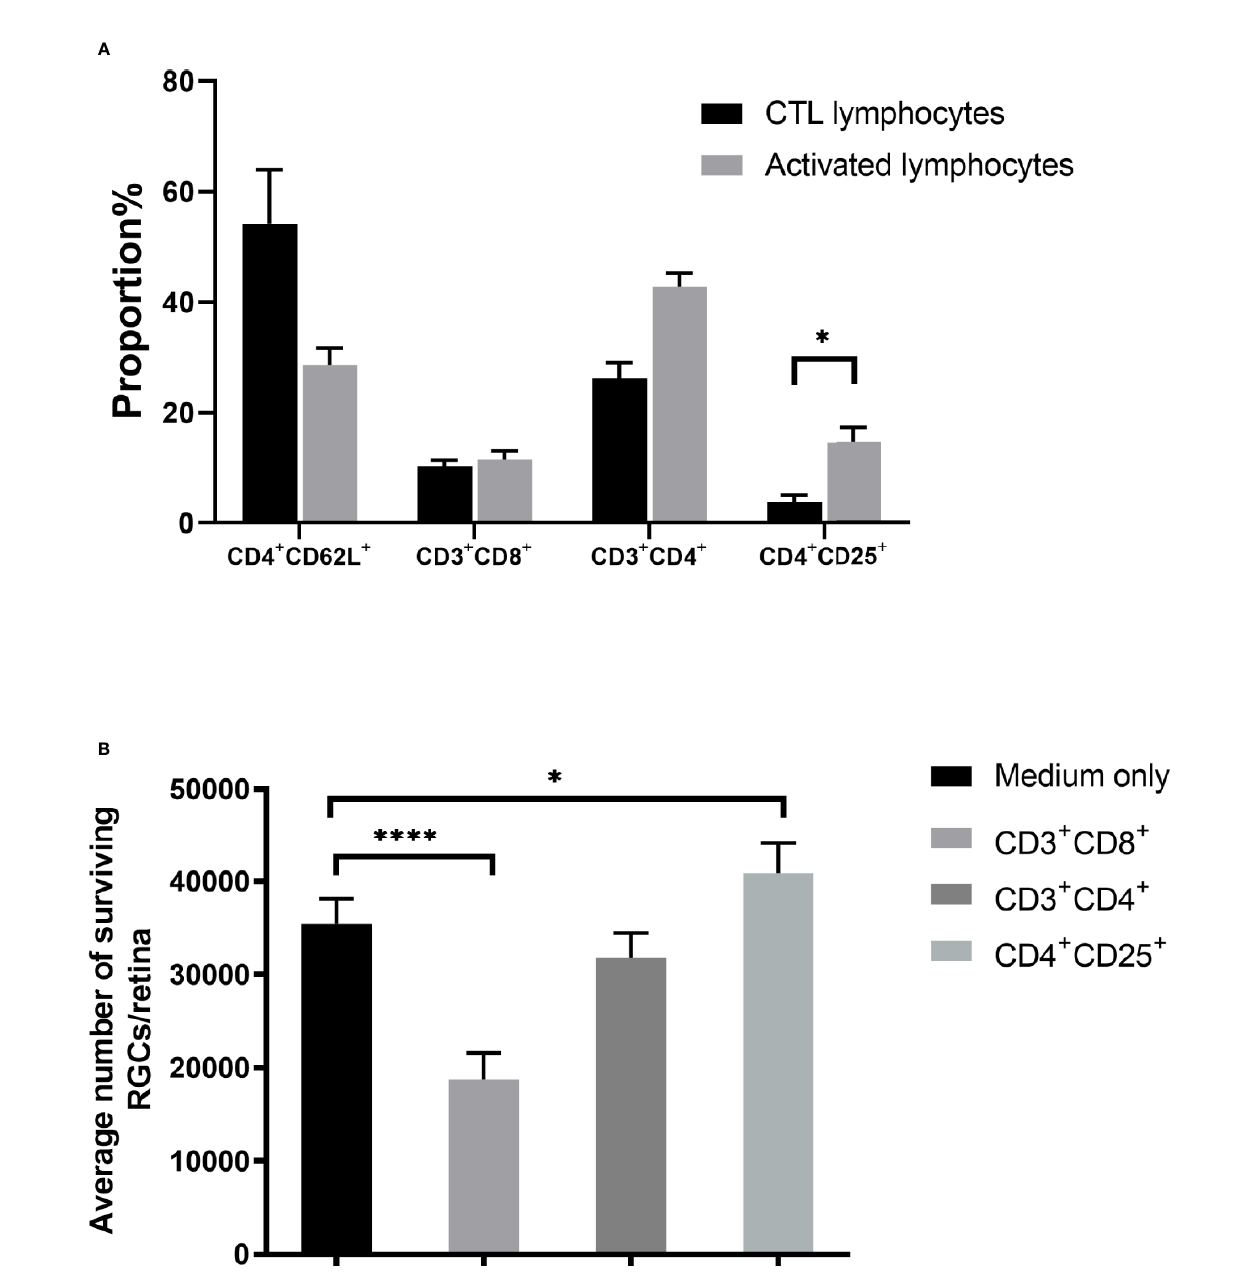
FIGURE 3 | Effect of T cell subsets on retinal ganglion cell (RGC) survival. (A) Compared with the control T cell co-culture, co-culture with activated T cells showed upregulation of CD4 + CD25 + T cells. (B) Co-culture of retinal explants with puri fi ed subgroups of activated T cells showed that CD3 + CD8 + T cell co-culture decreased RGC survival, whereas RGC survival with CD3 + CD4 + T cell co-culture was similar to that of control. RGC survival was even higher when co-cultured with CD4 + CD25 + T cells than in the medium-only control (n=4-5 for each group). * P < 0.05, **** P <